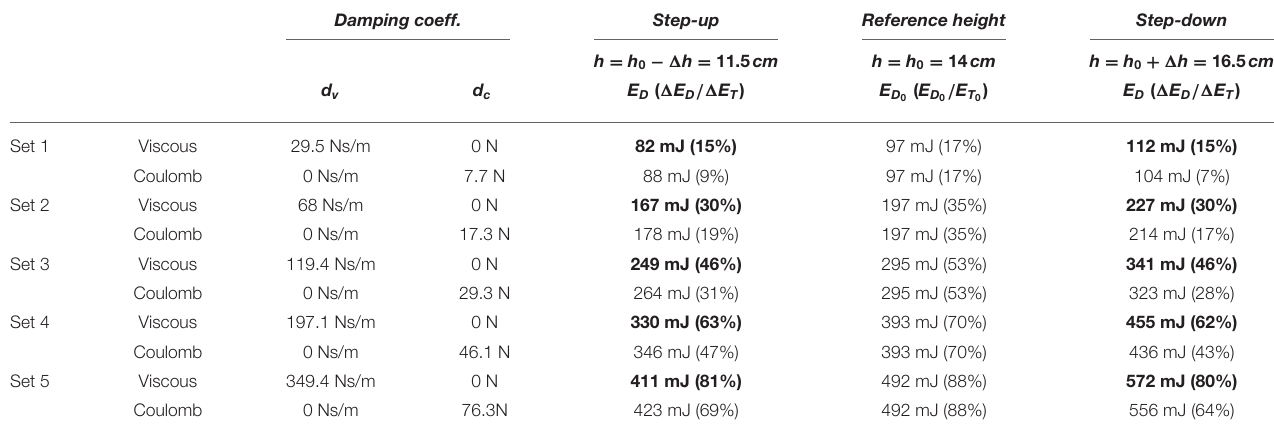
TABLE 2 | Numerical simulation. Damping coeff. Step-up Reference height